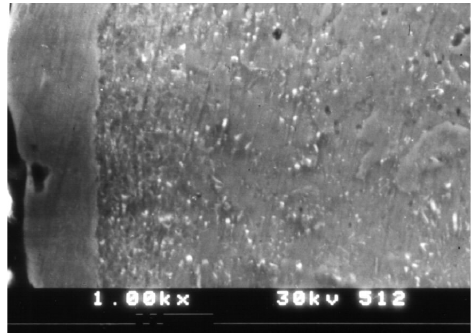
Figure 2: SEM micrograph of recast layer on HS 6-5-2 steel after electrical discharge treatment in electrolyte